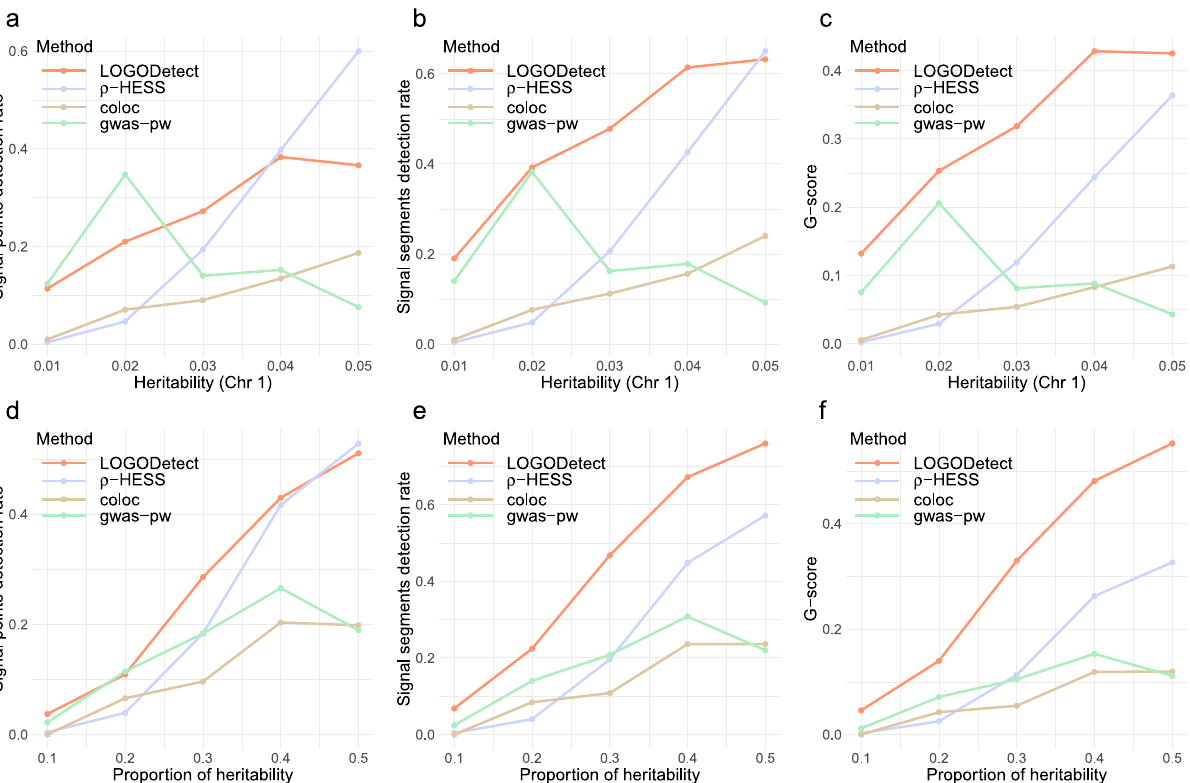
Fig. 2 Assessment of statistical power under a heritability-enrichment model with varying trait heritability and heritability enrichment. The Y -axis shows the statistical power assessed by three different metrics: a , d signal points detection rate measures sensitivity at the SNP level, b , e signal segments detection rate measures sensitivity at the segment level, and c , f G -score jointly measures speci fi city and sensitivity. The heritability represents the trait heritability on chromosome 1 and the proportion of heritability represents the proportion of the trait heritability explained by the signal regions. Signi fi cance cutoffs for gwas-pw are adjusted so that the empirical type I error rate is controlled at 0.05. Details on the above three metrics and the adjustment